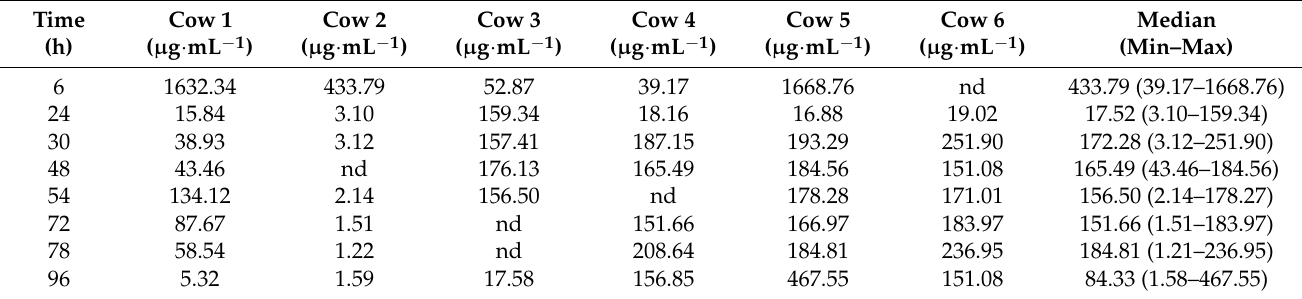
Table 3. Measured individual concentrations of oxytetracycline in uterine secretion ( n = 6) after the third intrauterine dose (8 mg/kg) of 10% solution of